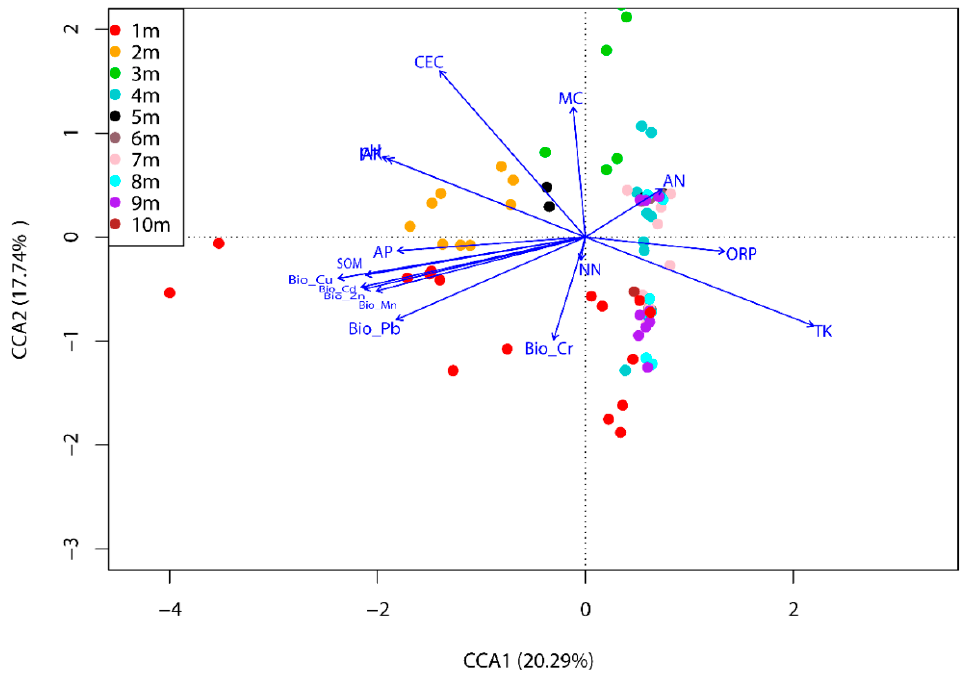
Figure 8. Ordination diagrams from CCA of environmental conditions with overall microbial data.